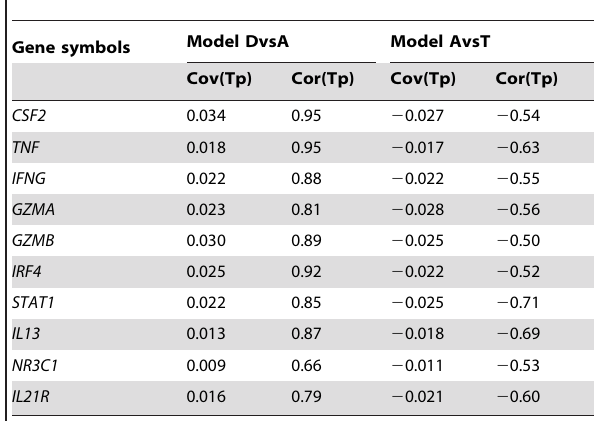
Table 2. Genes of known relevance for allergy, whose expression increased following allergen-challenge and were reversed by treatment with